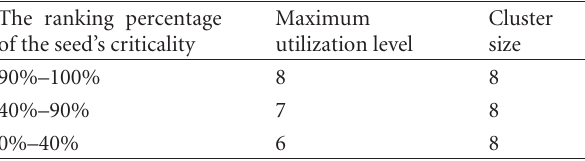
Table 2: A maximum utilization table